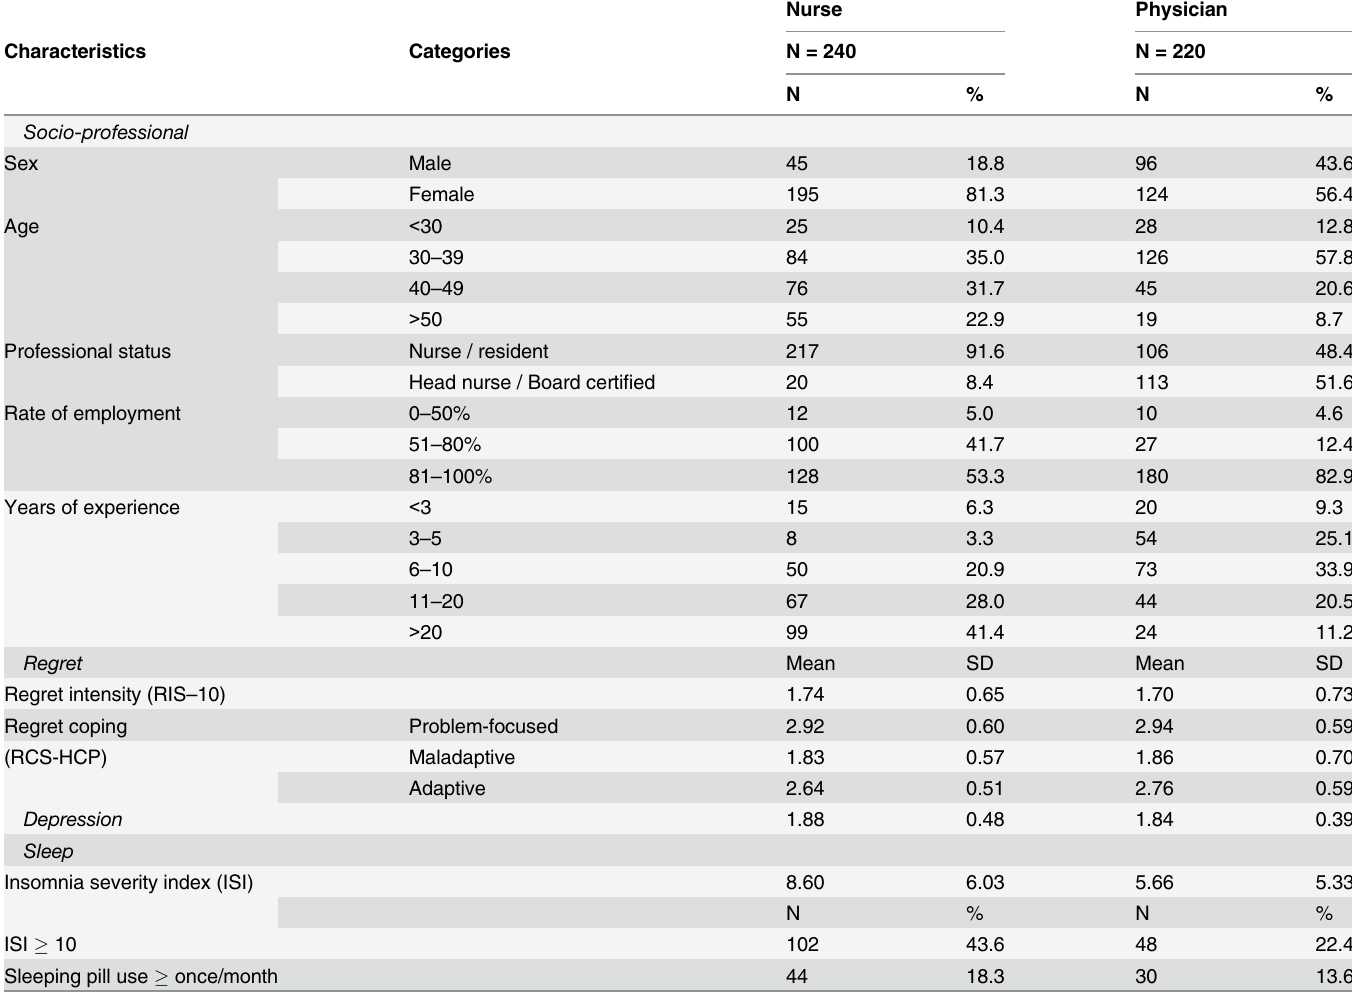
Table 1. Baseline characteristics of 460 healthcare providers at University Hospitals of Geneva, Switzerland,